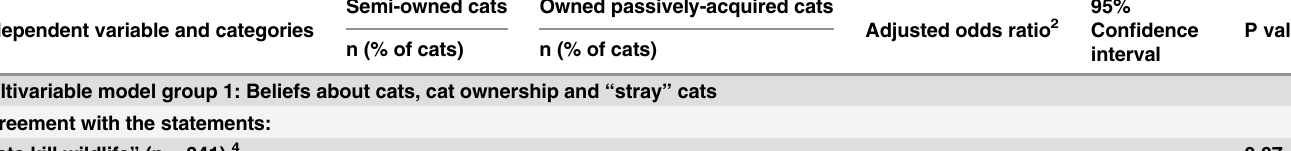
Table 1. Distributions of study cats in semi-ownership and ownership (of passively acquired cats) human-cat relationships, potential determi- nants of ownership perception and associations between these determinants and the perception of ownership of the study cat 1 . Semi-owned cats Owned passively-acquired cats Independent variable and categories n (% of cats) n (% of